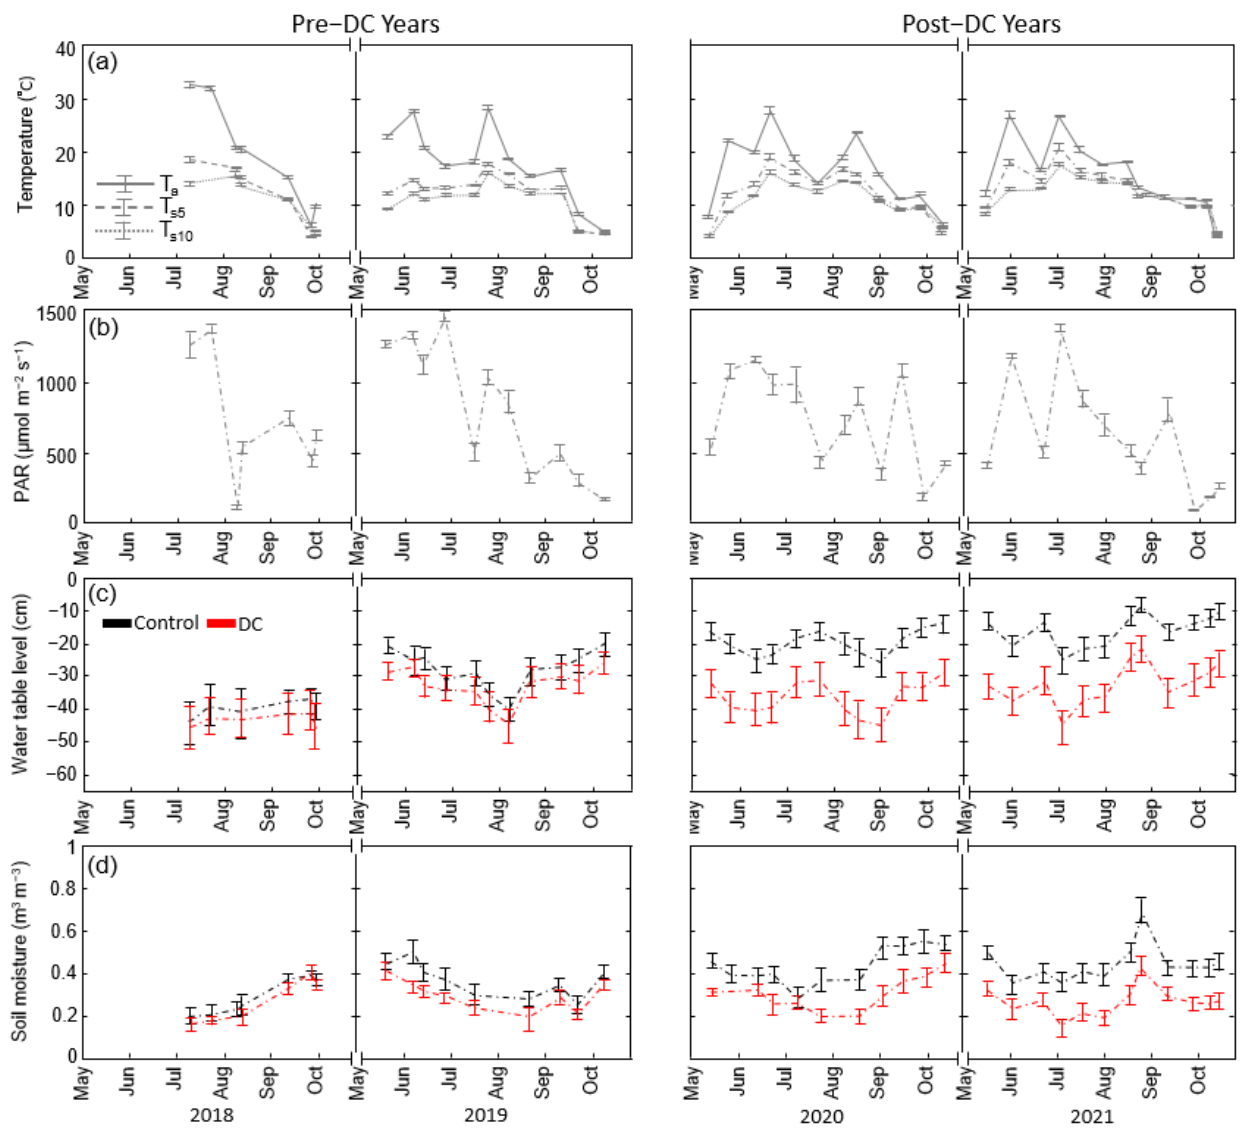
Figure 3. Environmental variables including ( a ) air (T a ) and soil temperature (T s5 at 5 cm and T s10 at 10 cm depth), ( b ) photosynthetically active radiation (PAR), ( c ) water table level (WTL), ( d ) soil moisture (SM) monitored at the measurement plots (shown as means of 4 m, 20 m and 40 m from ditch) during flux measurements. PAR, WTL and SM data are averaged for each sampling occasion and grouped by experimental area (control versus DC) and year (pre-DC years of 2018 and 2019 with post-DC year of 2020 and 2021). The variable means of each sampling occasion ± standard error (SE) are presented for both control and DC areas ( n = 12),